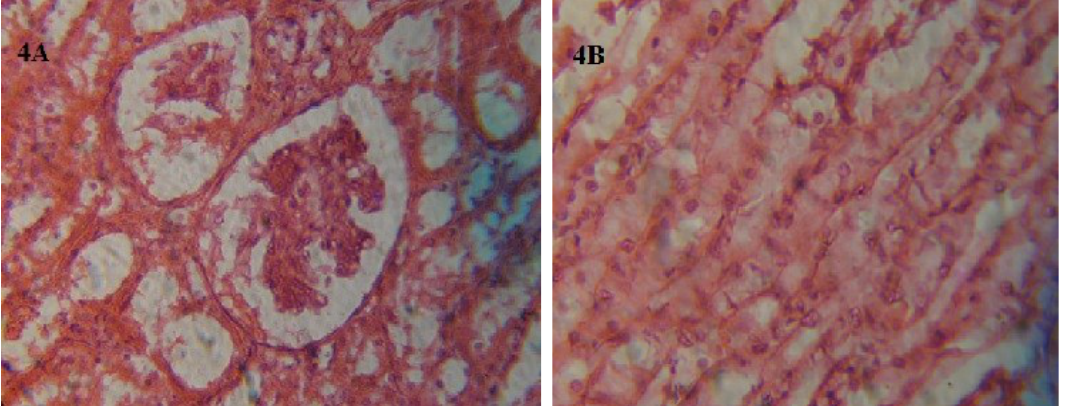
Figure 3: Microphotographs of Group G (Gentamicin treated); (3A) renal cortex presenting glomerular atropy with hydropic changes, hyaline filled lumina, necrosis and loss of cellular pattern and (3B) renal medulla presenting loss of cellular pattern with a number of ruptured and dilated collecting tubules.